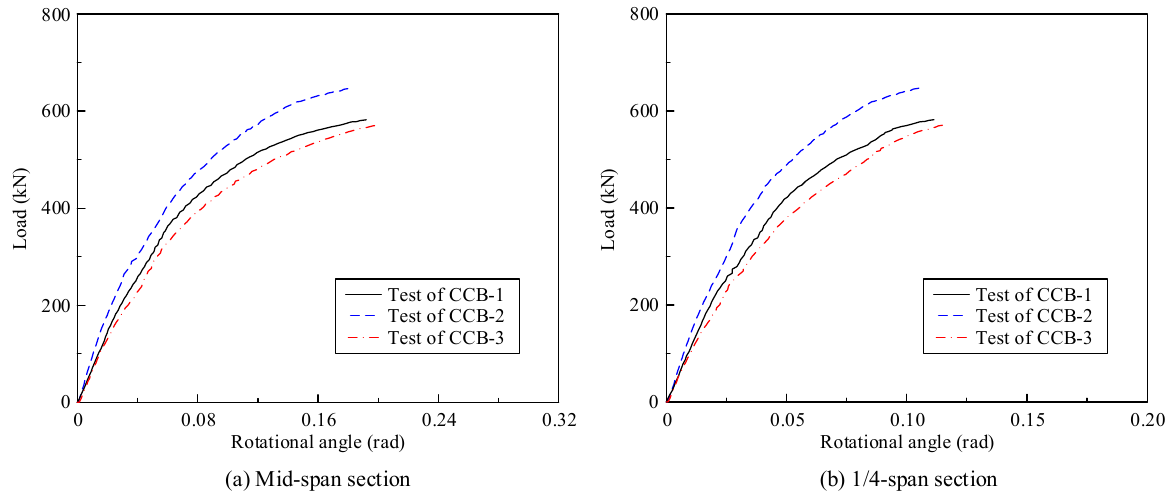
Figure 9. Load–rotational angle curves of the test specimens.